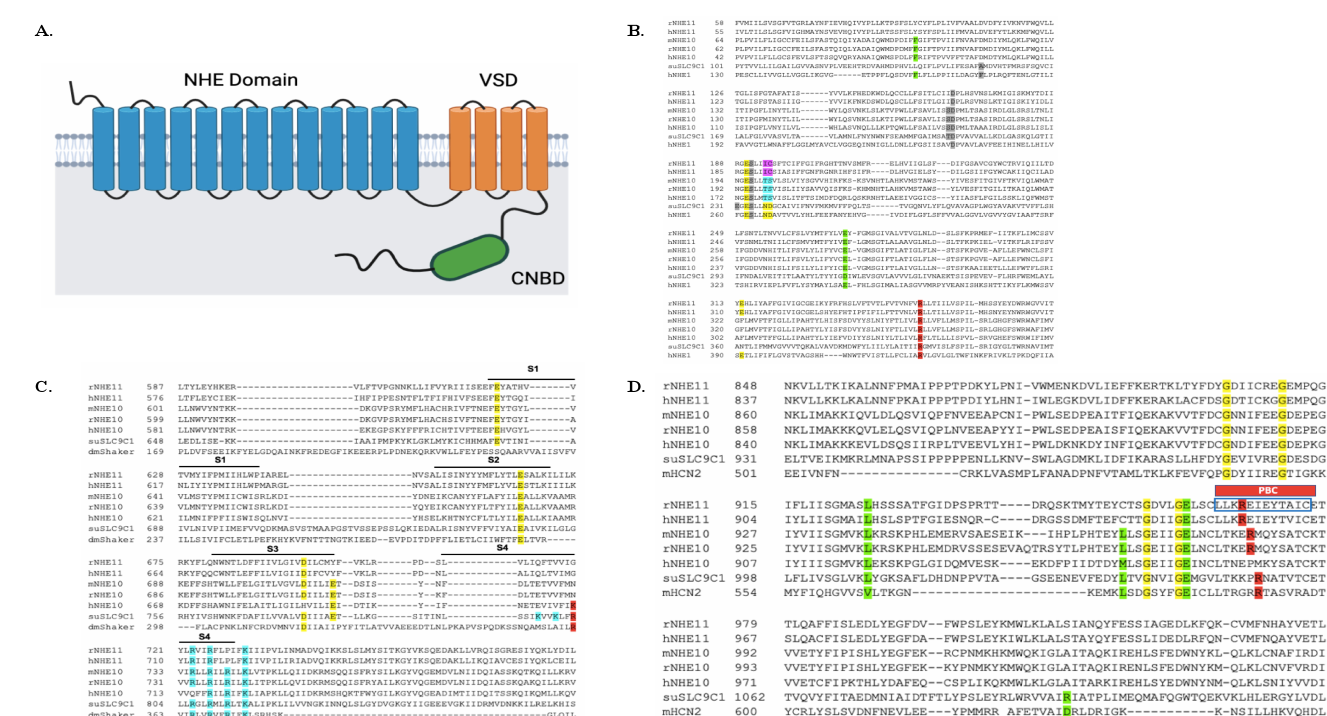
Figure 2. Predicted topology of mammalian NHE11, and sequence alignment comparisons. ( A ) Predicted topology and functional domains of both the rat and human NHE11 protein structure. NHE11 is predicted to be a 17 transmembrane (TM) alpha helical protein with a short extracellular N-terminus and a longer intracellular C-terminus. An NHE domain is predicted within the first thirteen transmembrane domains of NHE11 towards the N-terminus. The VSD is predicted to be contained within the last four transmembrane domains. The long C-terminus of NHE11 is predicted to contain an intracellular CNBD. The protein topology was predicted using the TOPCONS web server [27] and the conserved protein domains were determined with NCBI’s Conserved Domain database [28]. NHE11 topology cartoon created with BioRender.com (accessed on 5 January 2023).